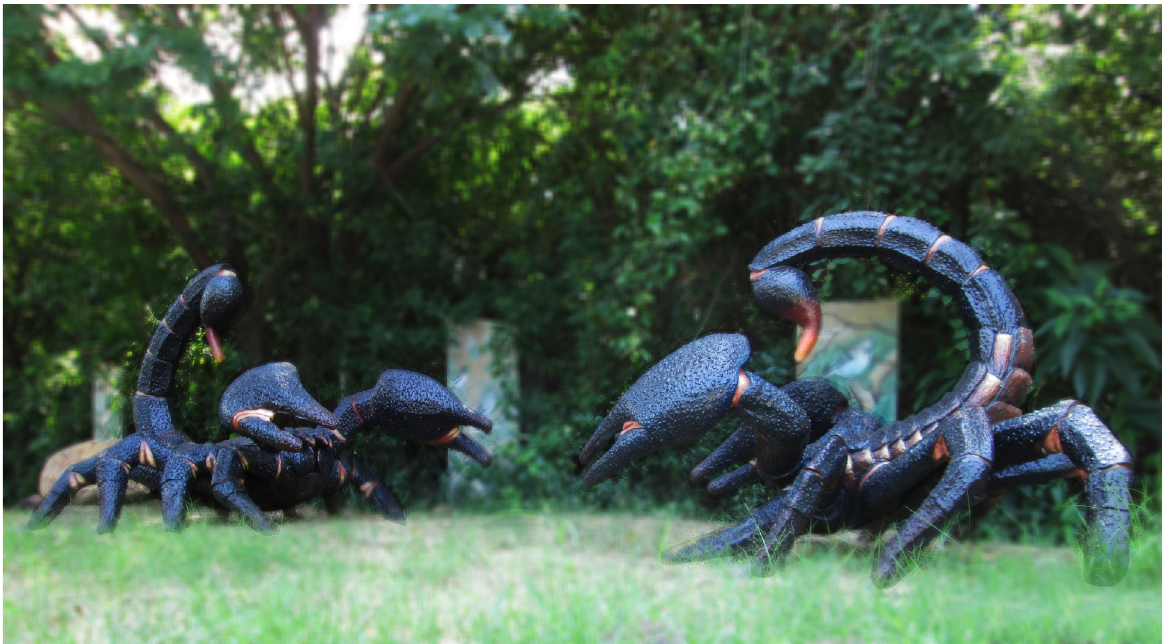
Image 5. Rock scorpions Heterometrus swammerdami facing each other. These are scaled-up versions approximately 3m long each. Adyar Eco Park,